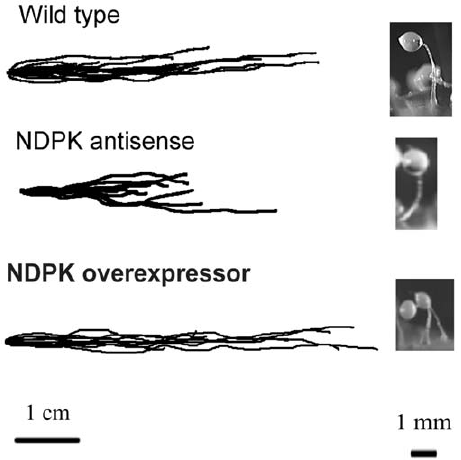
Figure 3. NDPK has no effect on phototaxis or fruiting body morphology. A:NDPK antisense-inhibited strains and NDPK overex- pressing strains displayed accuracies of phototaxis in the wild type range. The light source is to the right of the figure. B:Fruiting body morphology was also unaffected in the transformants with their morphology resembling the wild type.